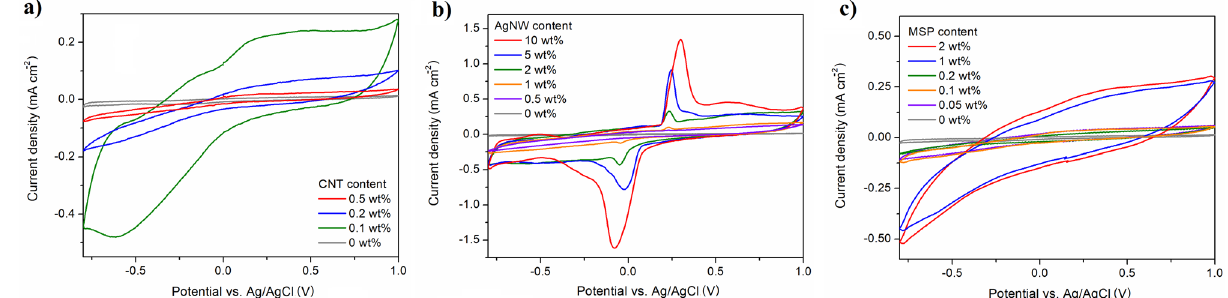
Figure 3. Electrochemical behaviour of EDL-based composites. Cyclic voltammetric curves of EDL/CNT ( a ), EDL/AgNW ( b ) and EDL/MSP ( c ) composites collected in 0.1 M KCl solution within the potential range from − 0.8 to 1.0 V (vs. Ag/AgCl) at 100 mV s −1